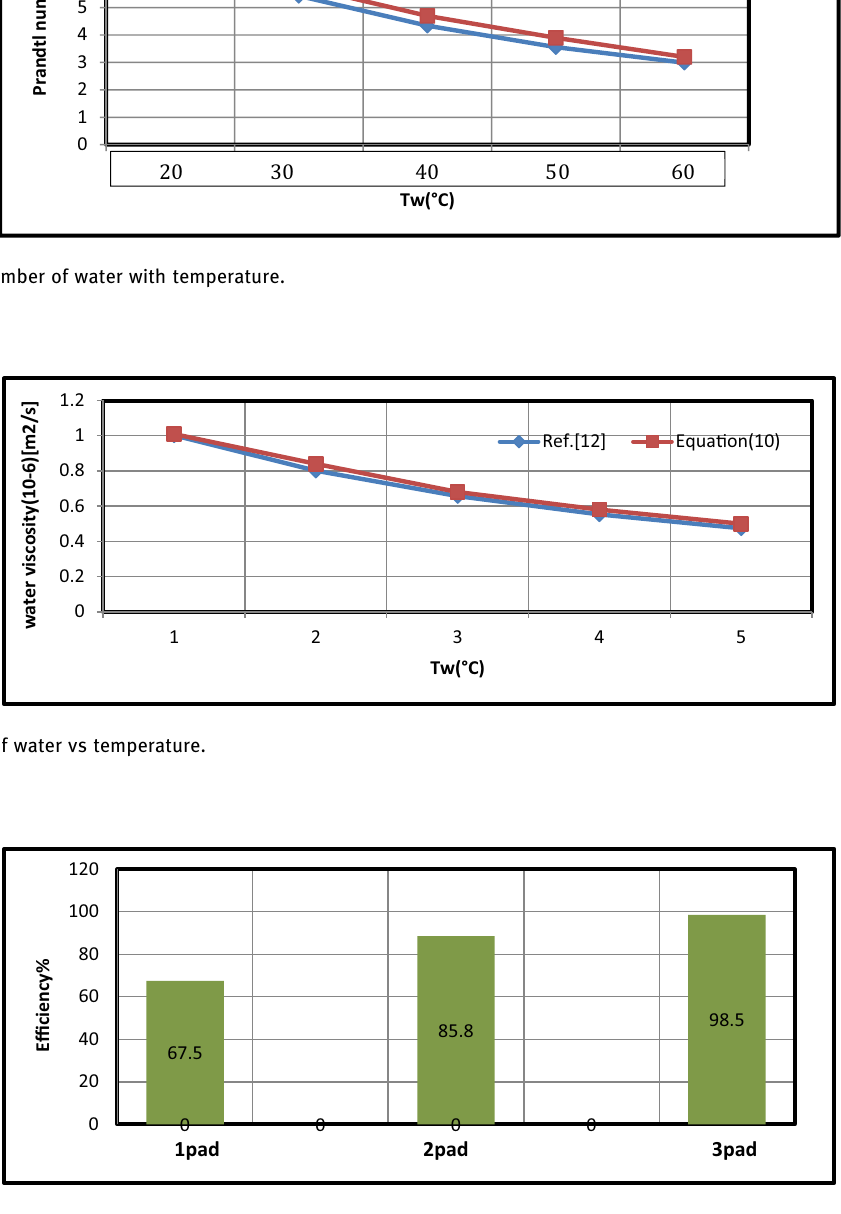
Figure 12: Evaporative e ffi ciency with di ff erent